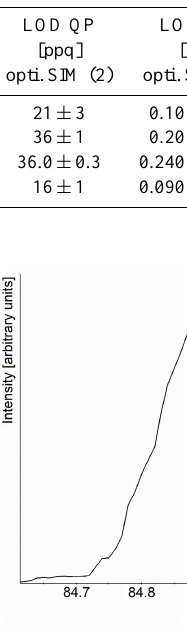
Figure 4. So-called 0.01u mass spectrum of the substance Trichloromethane. Two mass peaks are shown. The higher one by mass 84.9u is identified as the molecule fragment (CH 35 Cl 37 Cl + ) and the other one by mass 85.1u is an unidentified hydrocarbon